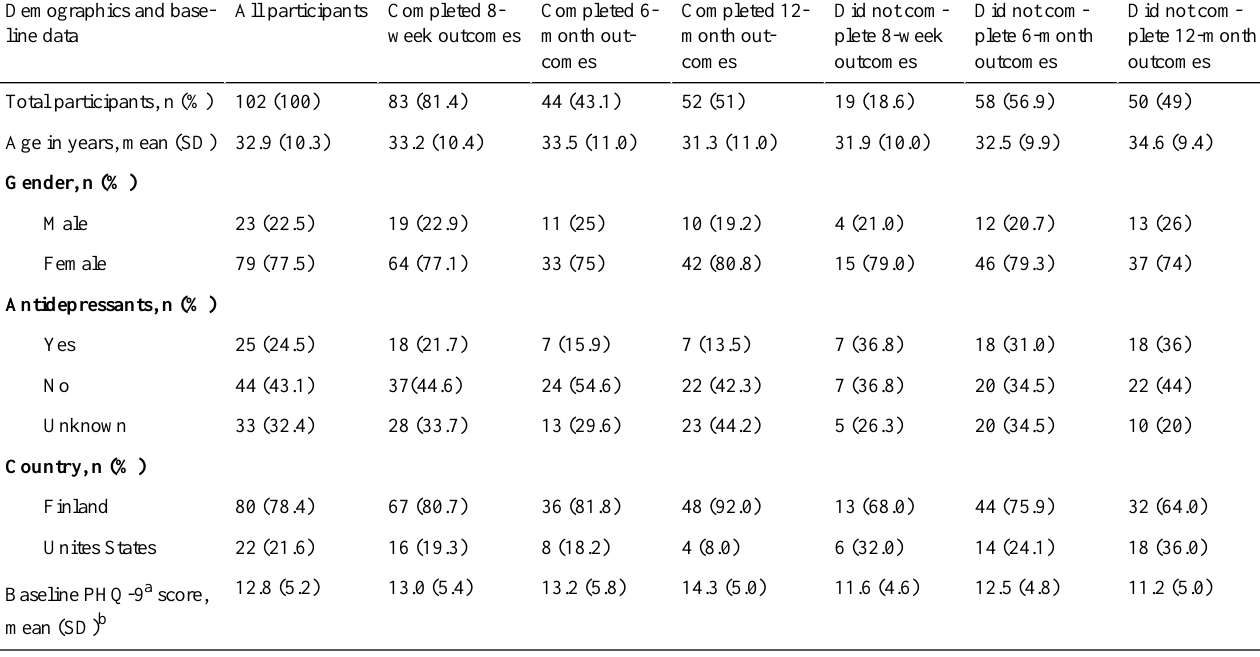
Table 1. Participant demographics and relevant baseline data for the primary study cohort (with Patient Health Questionnaire-9 outcomes available up to 12-months